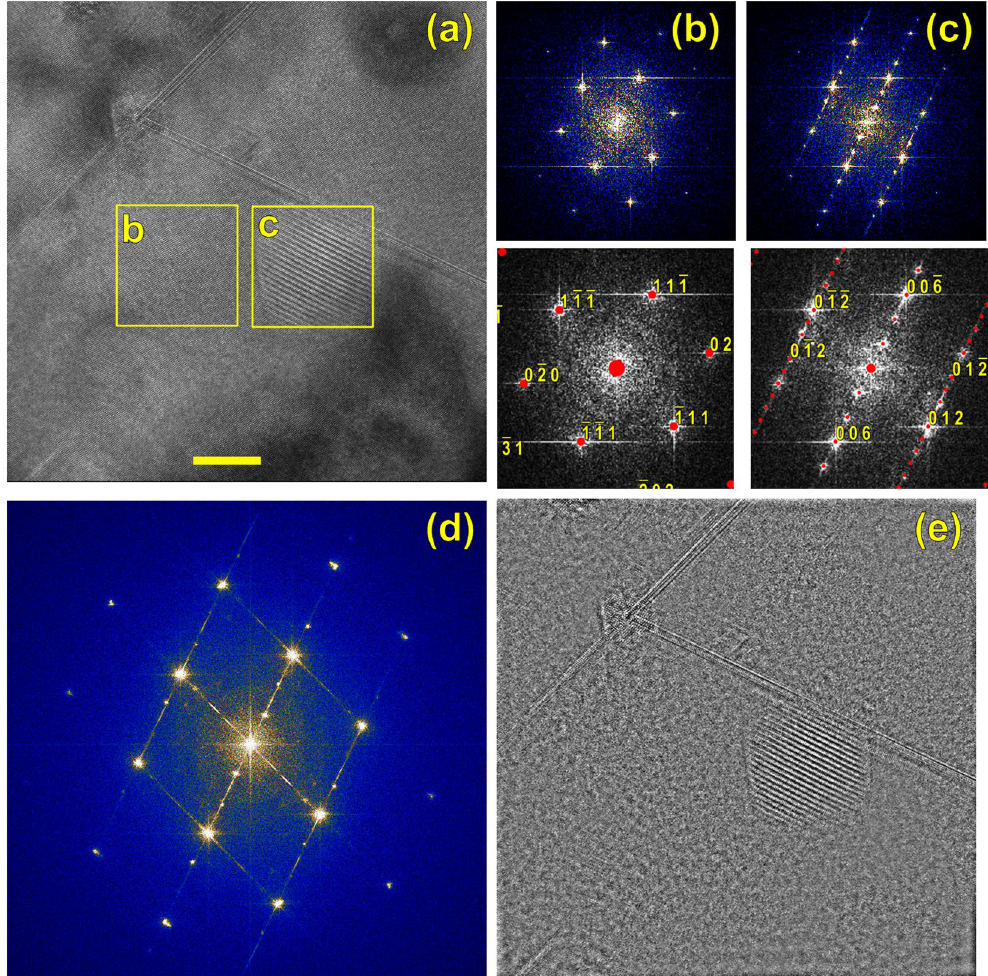
Figure 3. HRTEM image on the [101] matrix zone. Boxes marked “b” and “c” denote the Fourier transforms of ( b ) and ( c ), which also show calculated diffraction patterns for 3C and 6H SiC. ( d ) The Fourier transform of the entire image, showing dislocation streaks, cubic spots, and precipitate spots. ( e ) Inverse Fourier transform after the cubic spots were removed from ( d ); only the precipitates and dislocations remain. Scale bar 10